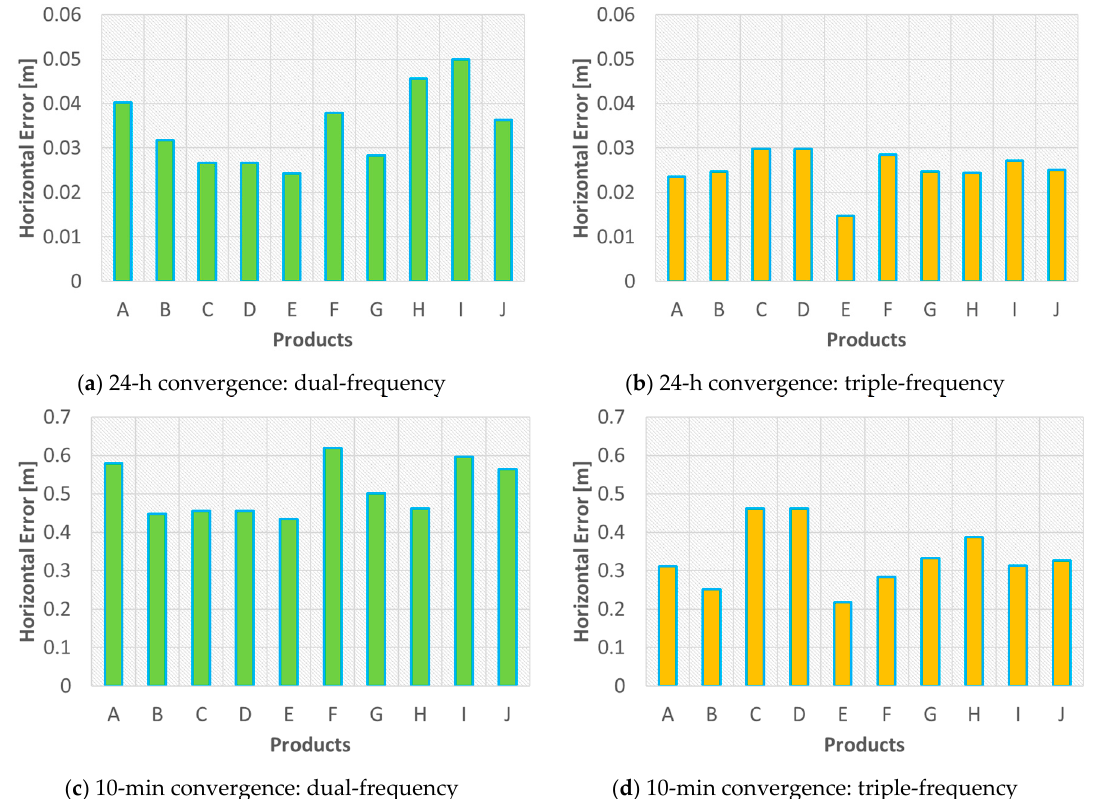
Figure 2. Analyses for 24-h and 10-min convergence for different existing GIM products using 3 days of 24-h observations from MGEX multi-GNSS stations.